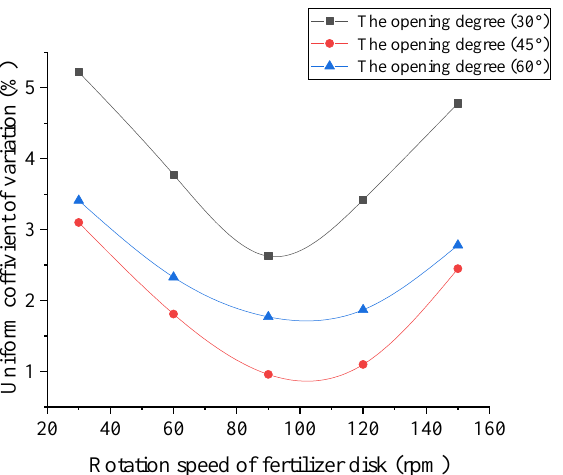
Figure 7. Variation of coefficient of variation of fertilizer discharge with rotational speed under different opening degrees.